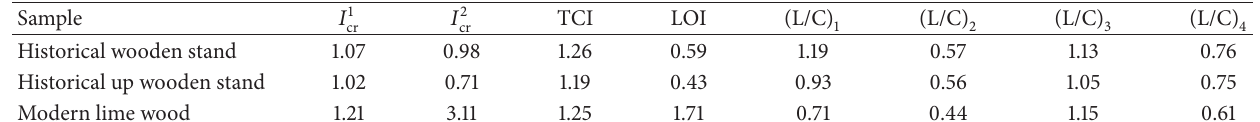
Table 1: Conservation state of lime wooden samples.